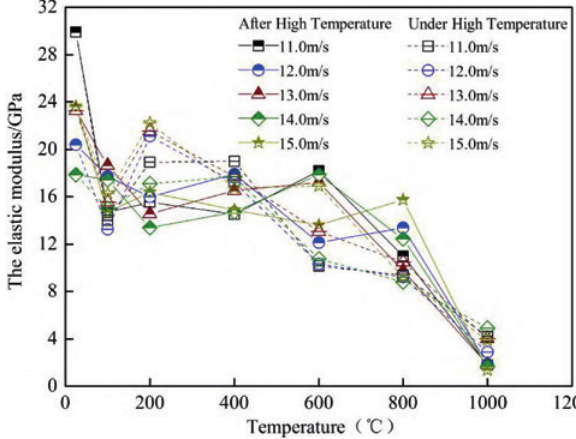
Fig. 7: The peak stress variation of sandstone after as well as under high temperatures